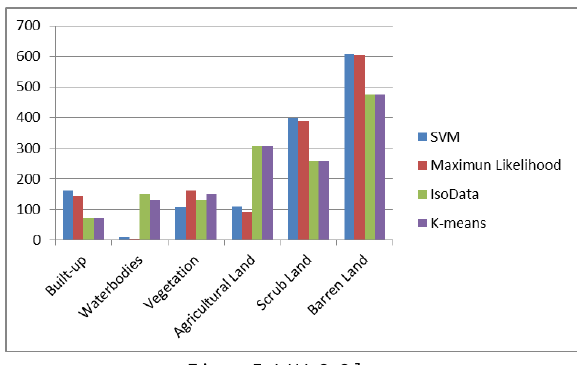
Figure 5. LULC Classes